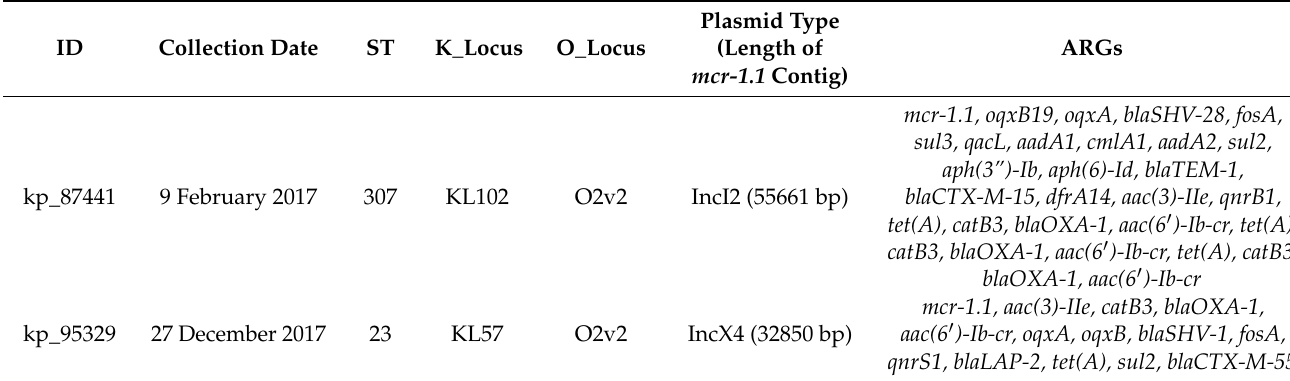
Table 2. Characteristics of mcr- positive K. pneumoniae isolates.